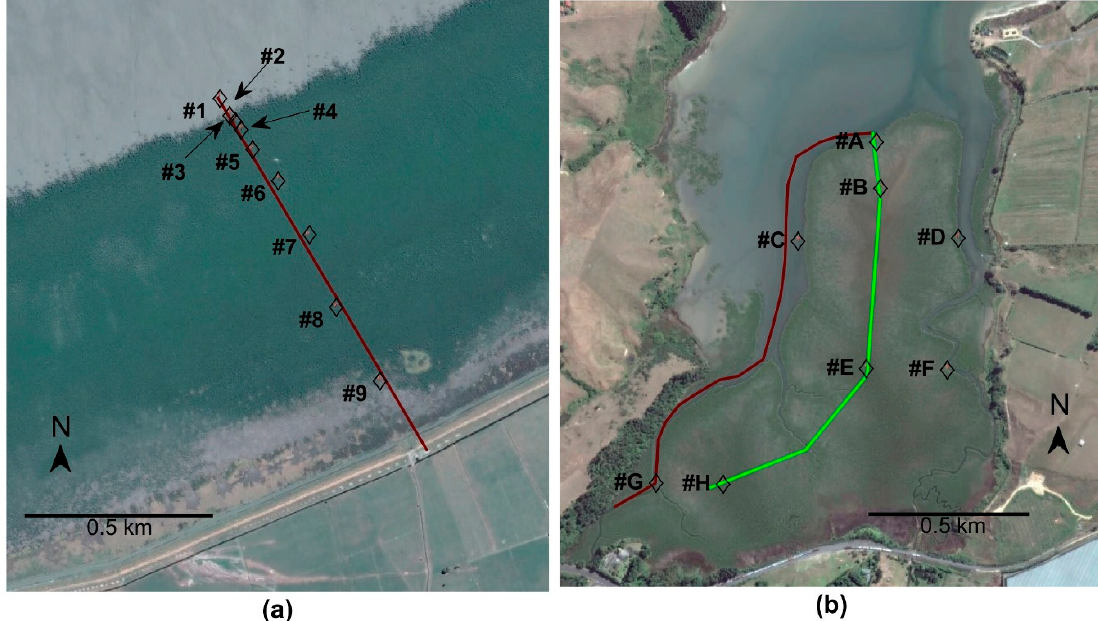
Figure 2. ( a ) The Firth of Thames study site with 9 (#1 seaward–#9 landward) instrument locations noted and bathymetry survey transect (brown). Station #1 is on the unvegetated mudflat, station #2 is in the vegetation fringe, stations #3–#5 are in the gently sloping intertidal, and stations #6–#9 are on the intertidal flat; ( b ) The Tauranga study site with 8 instrument locations noted with channel thalweg bathymetry survey (brown) and central mangrove survey (green). Station #A is on the vegetation fringe on the seaward boundary, stations #C and #D are in the western channel, stations #B, #E, and #H are in the central mangrove forest, stations #D and #F are in the eastern channel.